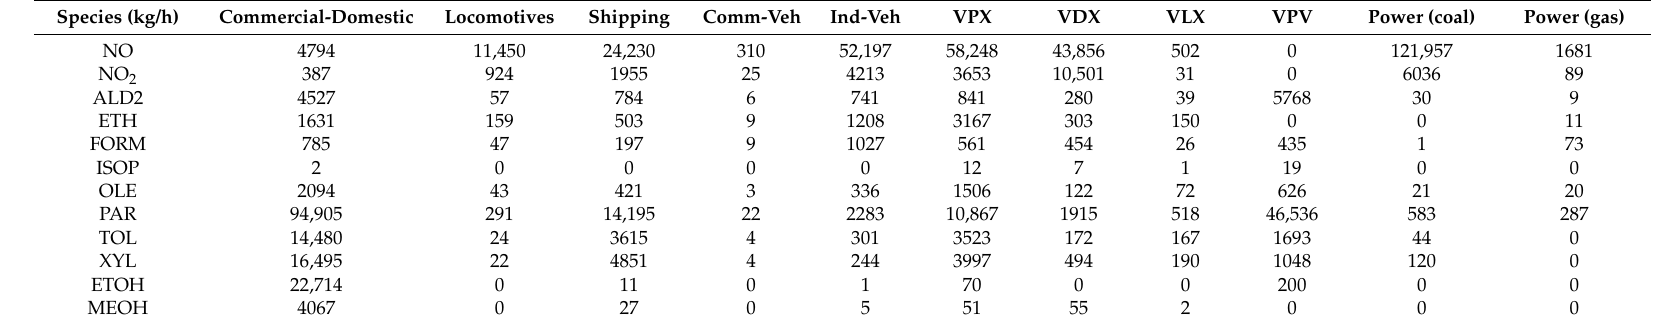
Table 1. Emission of NO x and VOC species from various area sources in the GMR for weekdays in January